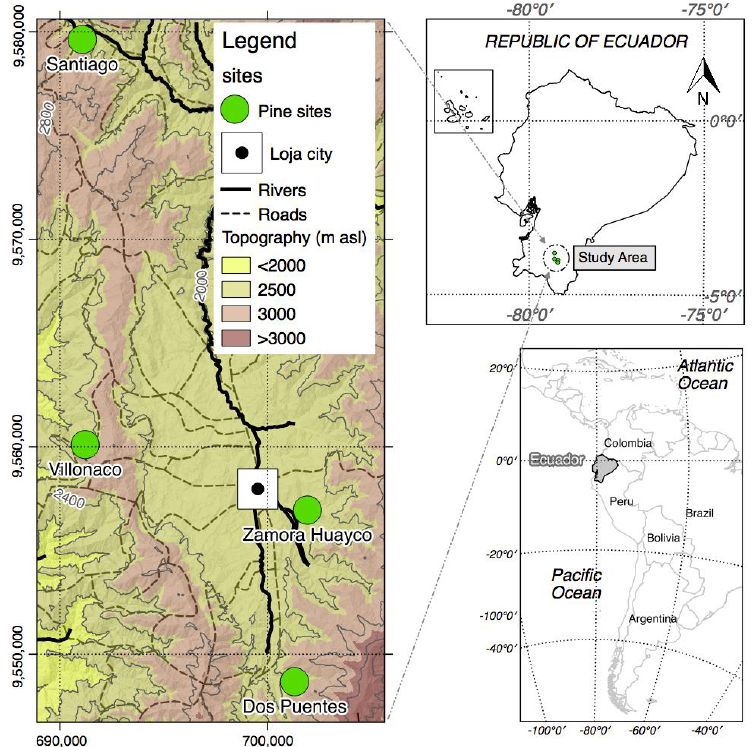
Figure 1. Location of the four sites of Pinus patula forest stands in the study region around Loja city in the south of Ecuador.